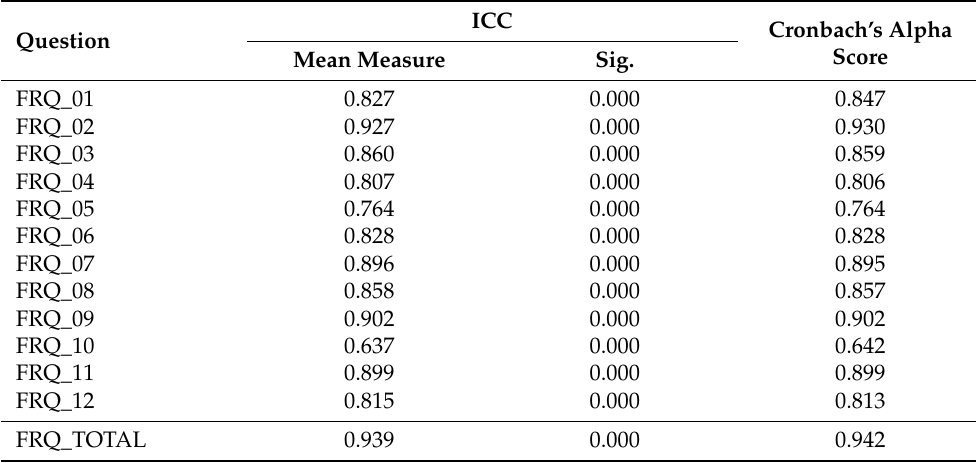
Table 5. ICC and Cronbach’s alpha score between O 1 and O